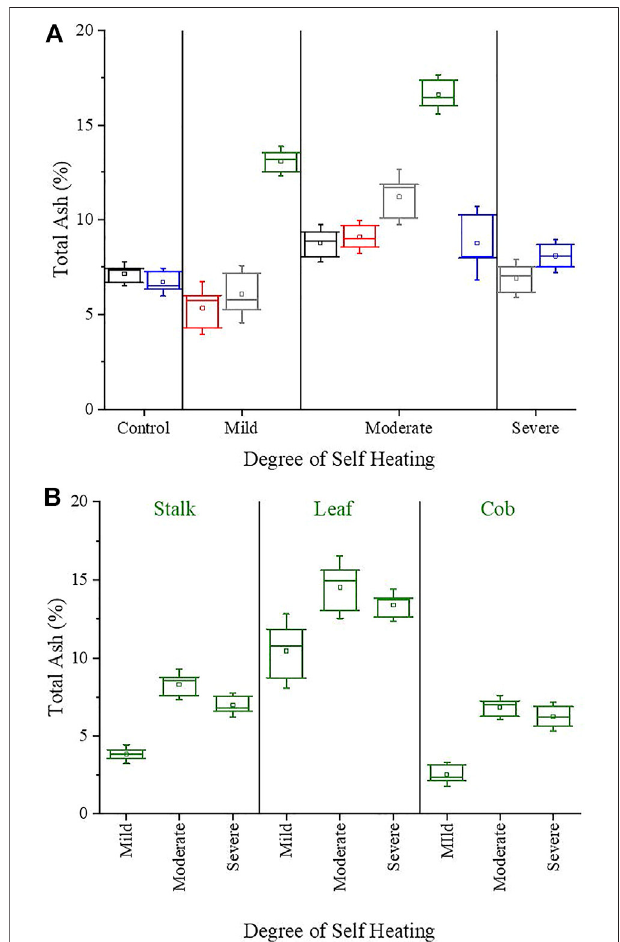
FIGURE 4 | (A) Total ash measurements of bulk bale samples; □ Bale 1, □ Bale 2, □ Bale 3, □ Bale 5, □ Bale 6. (B) Total ash measurements of fractionatedcornstoversamplesfromBale5[boxupperandlowerlimit=data max. and min., whiskers = sample standard deviation (Coeff. 1.5), solid horizontal line = median, hollow internal box =